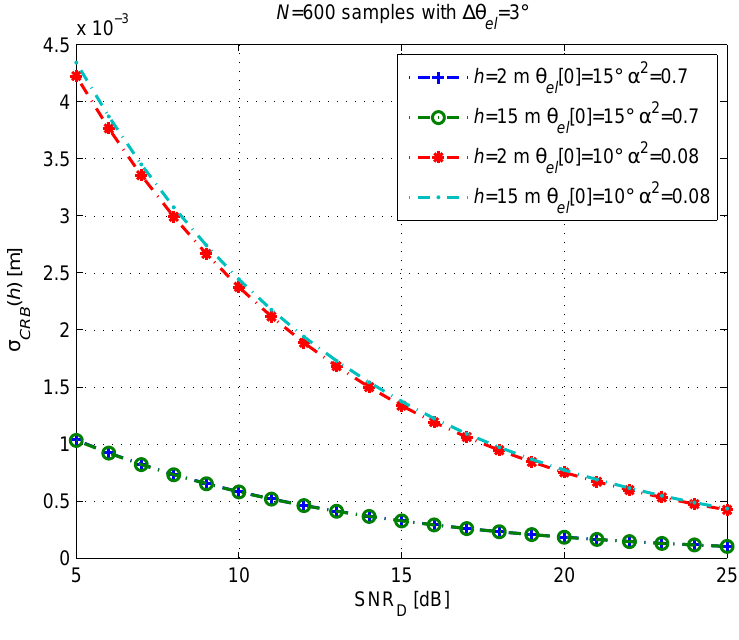
( h ) for different receiver heights and reflected/direct amplitude ratios ( α ) Figure 7. σ CRB versus